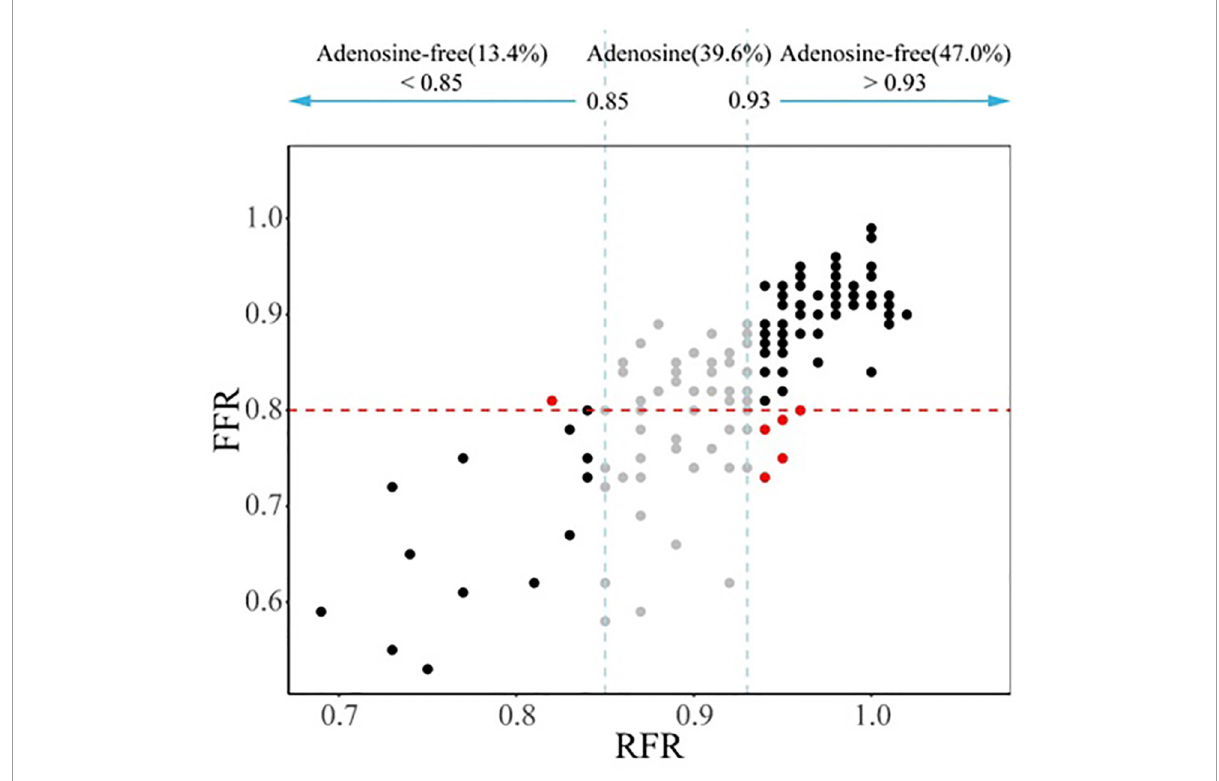
FIGURE5 Comparison between the hybrid RFR-FFR strategy and FFR-only strategy. RFR, resting full-cycle ratio; FFR, fractional flow